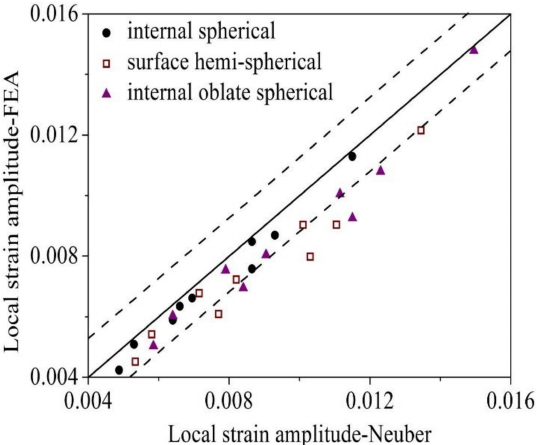
Figure 28. Calculated local strain amplitudes: FEA vs. Neuber’s method. Dotted lines indicate ± 10% error. Reprinted with permission from ref. [77], 208, Elsevier.